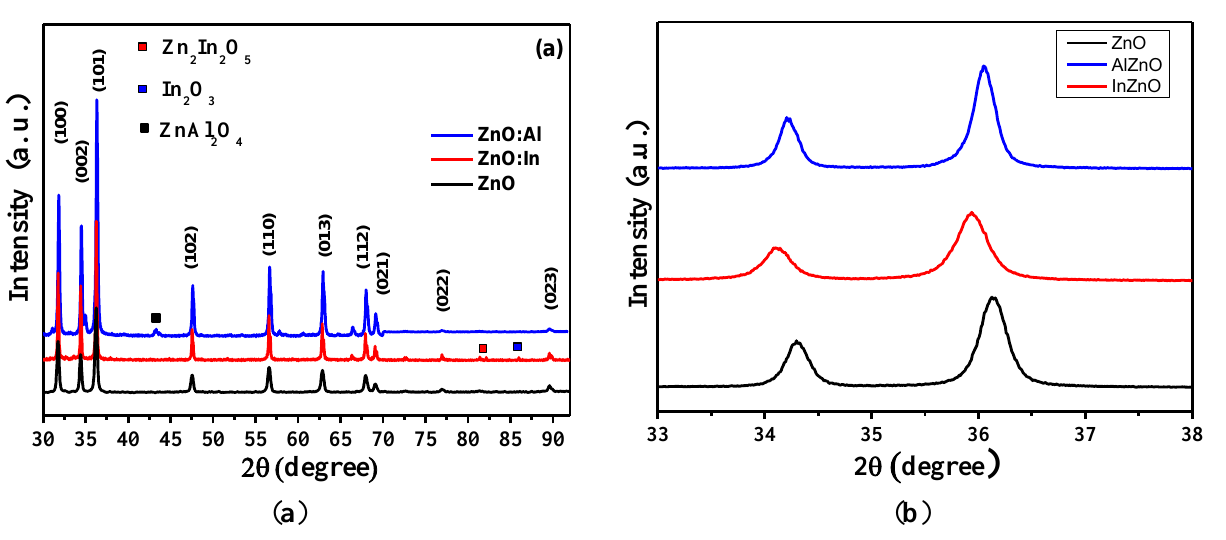
Figure 1. ( a ) X-ray diffraction spectra of as-prepared pure and doped ZnO